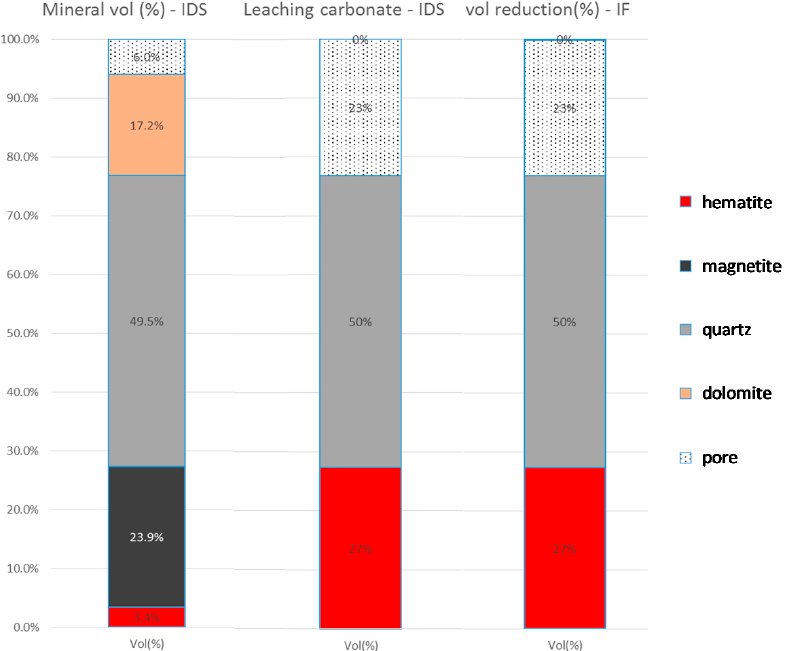
Figure 11. Original mineralogy and porosity in a volume of quartz-dolomite itabirite (IDS), leaching volume, and final result friable quartz itabirite (IF) with 23% of porosity without significant collapse.